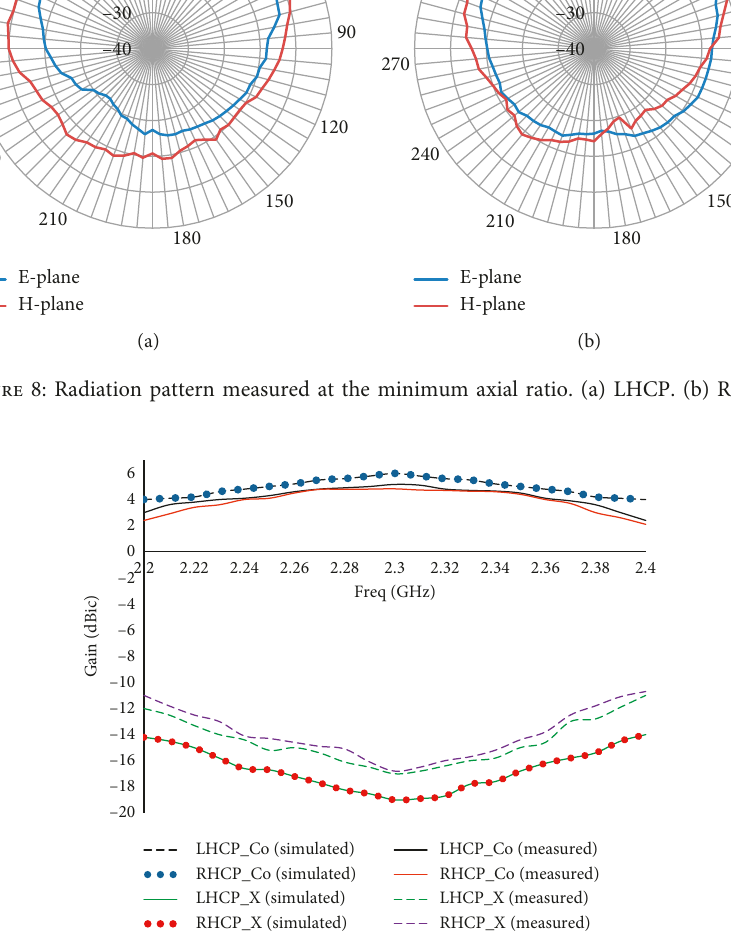
Figure 9: Variation of frequency (GHz) with respect to gain (dB). Table 2: Performance comparison of the proposed model with the traditional antenna model. Parameter Ref.